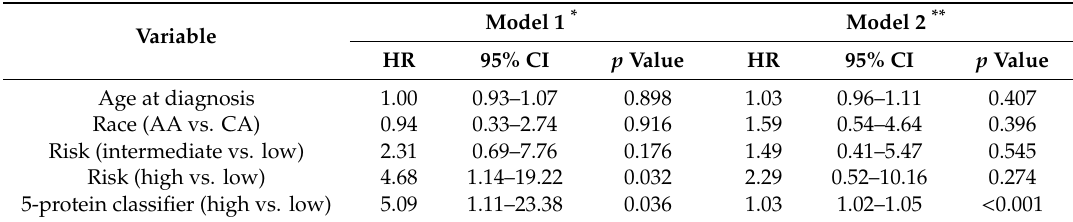
Table 5. Multivariable Cox proportional hazard model predicting DM as a function of a 5-protein classifier to complement biopsy SOC variables in study testing cohort.